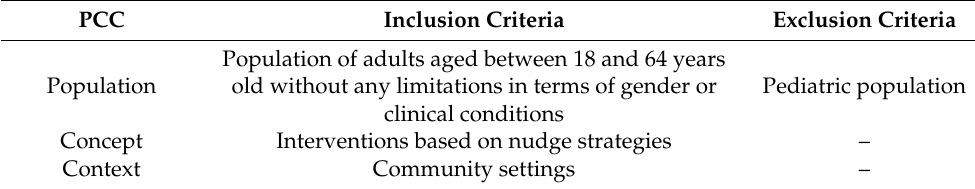
Table 1. Inclusion and exclusion criteria. PCC Inclusion Criteria Exclusion Criteria Population of adults aged between 18 and 64 years Population old without any limitations in terms of gender or Pediatric population clinical conditions Concept Interventions based on nudge strategies – Context Community settings – PCC: population, concept, and